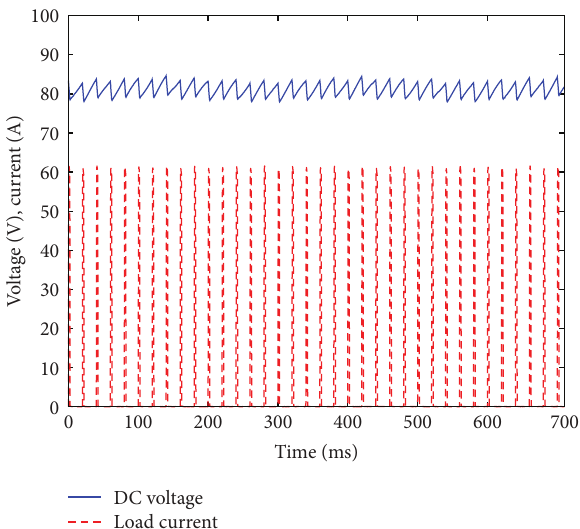
Figure 10: Load current and voltage while maintaining a 10.5% duty